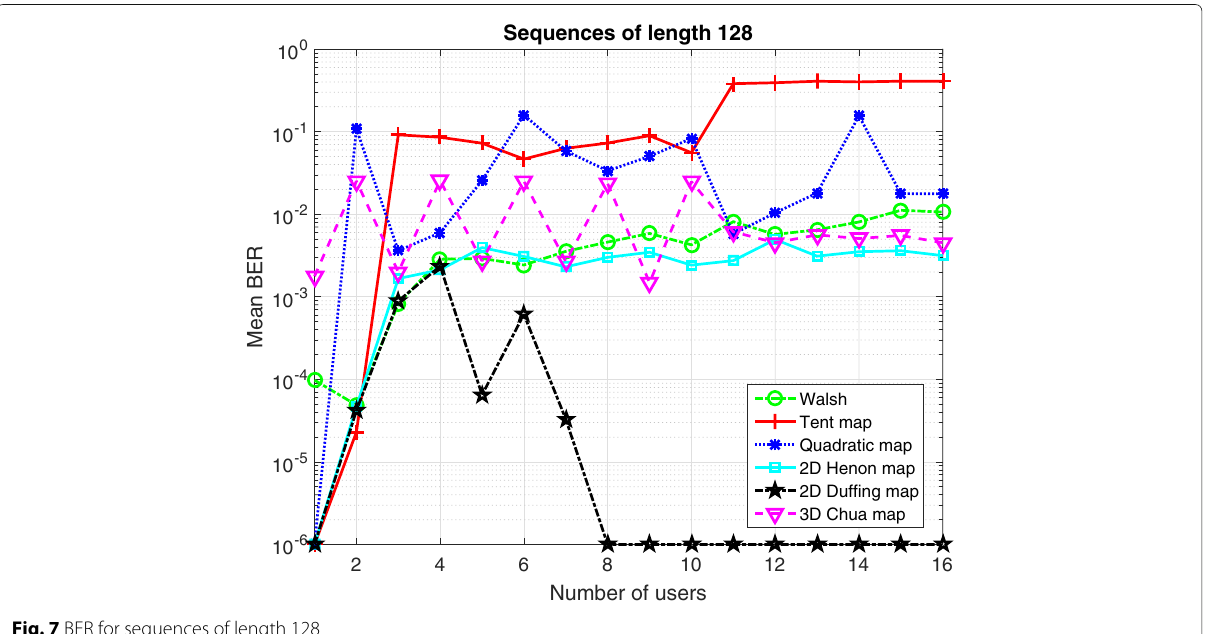
Fig. 7 BER for sequences of length 128